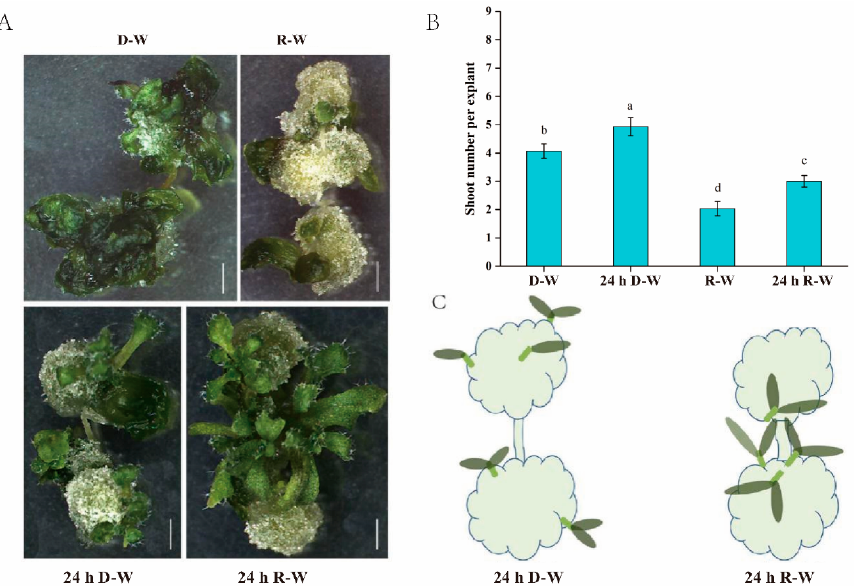
Figure 2. Effects of different light regimens on shoot regeneration number per explant, shoot growth vigor and shoot distribution. ( A ) Shoot morphology of explants under different treatments. The shoot growth vigor was severely inhibited under the R-W treatment, but was promoted under the 24 h R-W treatment. ( B ) Shoot number per explant under different treatments. In contrast with other treatments, average shoot number per explant under R-W treatment was significantly decreased. ( C ) Shoot distribution pattern under different treatments. The shoots were centralized to the middle location under the 24 h R-W treatment, but were widely distributed around callus under the 24 h D-W treatment. The shoot distribution pattern under the D-W or R-W treatments was similar to that of the 24 h D-W treatment. Error bars indicated the standard deviation from three independent experiments, each containing 120 root segments of Arabidopsis thaliana . The least significant difference method (LSD) was used for the significance test ( p < 0.05); different lowercase letters represent statistical differences in pairwise comparisons between LSD test groups ( p < 0.05).